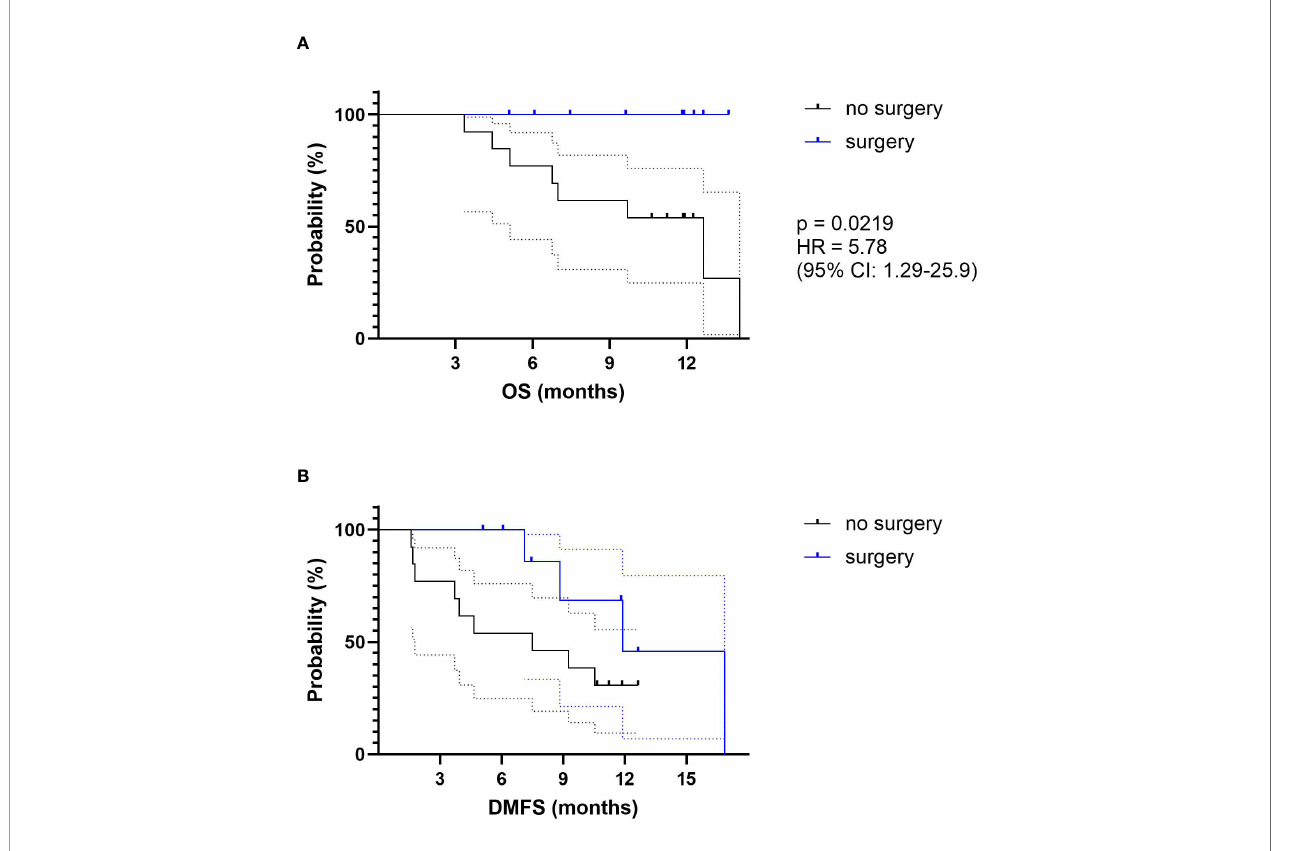
FIGURE 5 | Survival data for LAPC and BRPC patients: comparison between resected (in blue) and unresected patients (in black). (A) OS from SMART completion. (B) DMFS from SMART completion. OS, overall survival, DMFS, distant metastasis-free